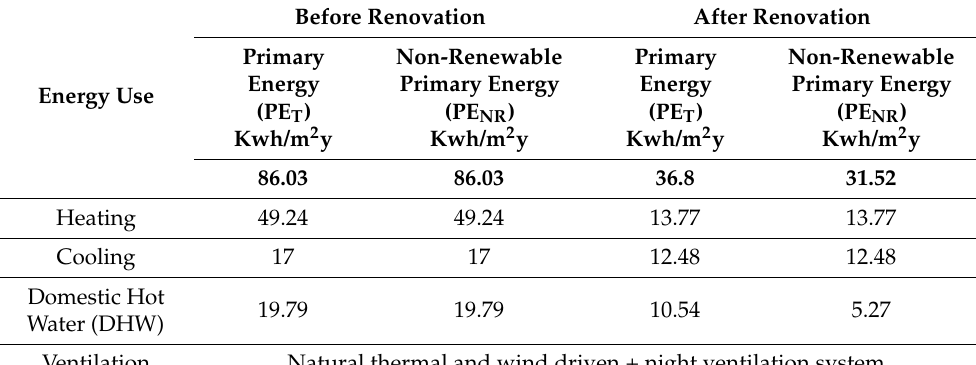
Table 8. Pilot building before and after renovation primary energy (PE)